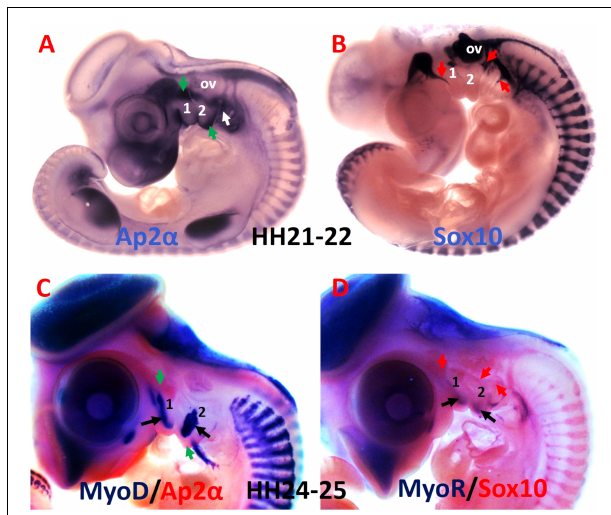
FIGURE 3 | Comparative analysis of the mesodermal and neural crest cell makers. (A,B) Whole-mount chicken embryos were hybridized with DIG-labeled probes for Ap2 α and Sox10. (C) Whole-mount embryos are labeled with MyoD probes in blue and Ap2 α probe in red. (D) Whole-mount embryos are labeled with MyoR probes in blue and Sox10 probe in red. Ap2 α marked the ectomesenchymal neural crest cells (green arrows), whereas Sox10 labeled non-ectomesenchymal neural crest cells (red arrows). The myogenic cells are marked by MyoD and MyoR (black arrows). 1-2, branchial arches 1-2; ov, otic